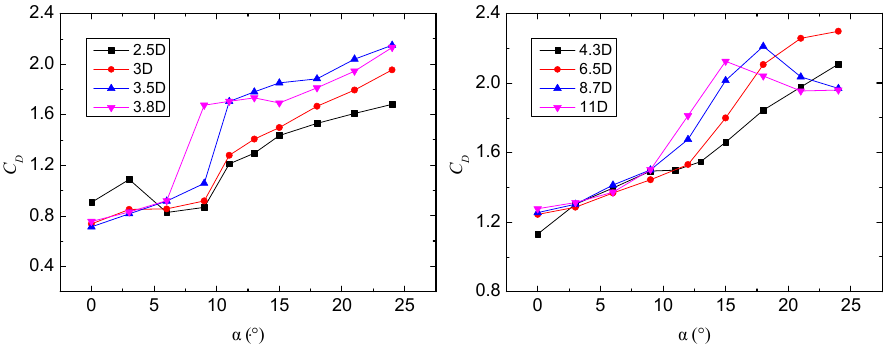
Figure 9. Drag coefficients of coupled twin cylinders with various spacings.